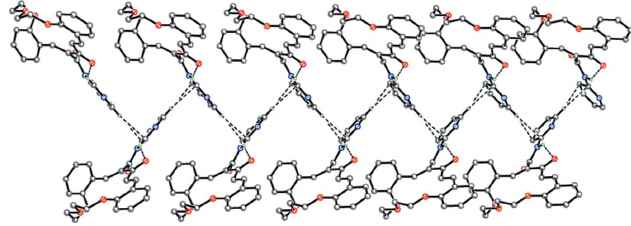
Figure 2 The chain of molecules of ( 3 ) along the c axis. Dashed lines indicate the intramolecular N—H (cid:2)(cid:2)(cid:2) O hydrogen bonds and the intermolecular C— H (cid:2)(cid:2)(cid:2) (cid:3) contacts.